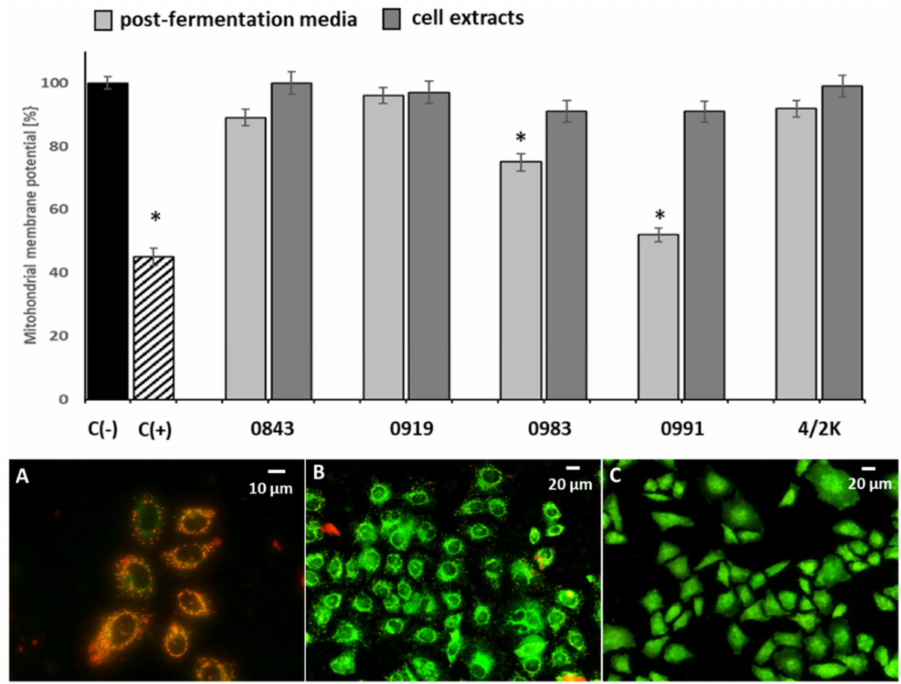
Figure 3. The effect of 5% ( v/v ) post-fermentation media (PFM) and cell extracts (CEs) on mitochon- drial membrane potential (MMP) depletion in Caco-2 cells after 24 h exposure. Each data point represents the mean ± SD, n ≥ 4. * Results significantly different from unexposed control cells, C( − ), p ≤ 0.05: ( A – C ) representative microphotographs of MMP of Caco-2 cells determined with tetraethylbenzimidazolylcarbocyanine iodide (JC-1) as a fluorescent probe staining method: C( − ), untreated Caco-2 cells ( A ); Caco-2 cells exposed to 10% PFM of L. plantarum 0991 ( B ); C(+), CCCP, positive control (50 µ M) ( C ), observed under a fluorescent microscope (Nikon Eclipse Ci H600L, Japan) with 10 × and 20 ×